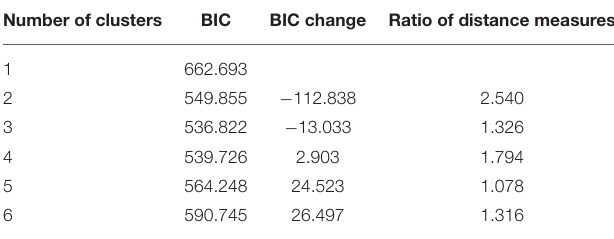
TABLE 2 | Information criteria values for different clustering solutions. Number of